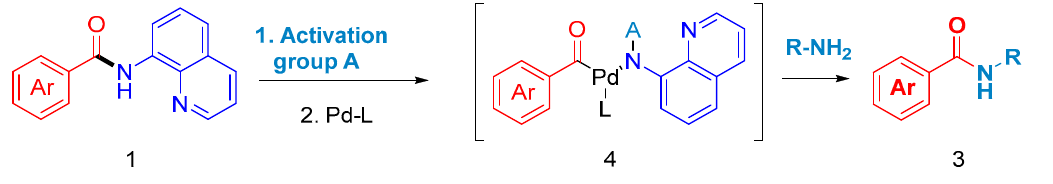
Figure 1. New strategy to remove 8-aminoquinoline (8-AQ).